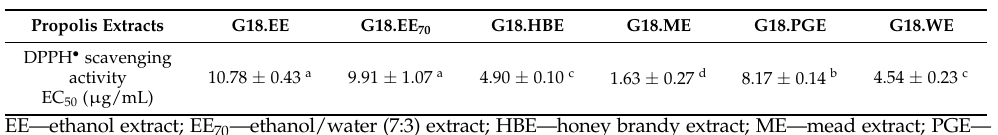
Table 4. Antioxidant potential of G18.EE, G18.EE 70 , G18.HBE, G18.ME, G18.PGE and G18.WE, measured by the in vitro DPPH free-radical-scavenging assay and expressed as a mean of EC 50 values ( µ g/mL) and respective standard deviation (SD). Statistical analysis was performed by one- way ANOVA followed by Tukey’s test for multiple comparisons. Mean values with the same letters (a, b, c or d) are not statistically